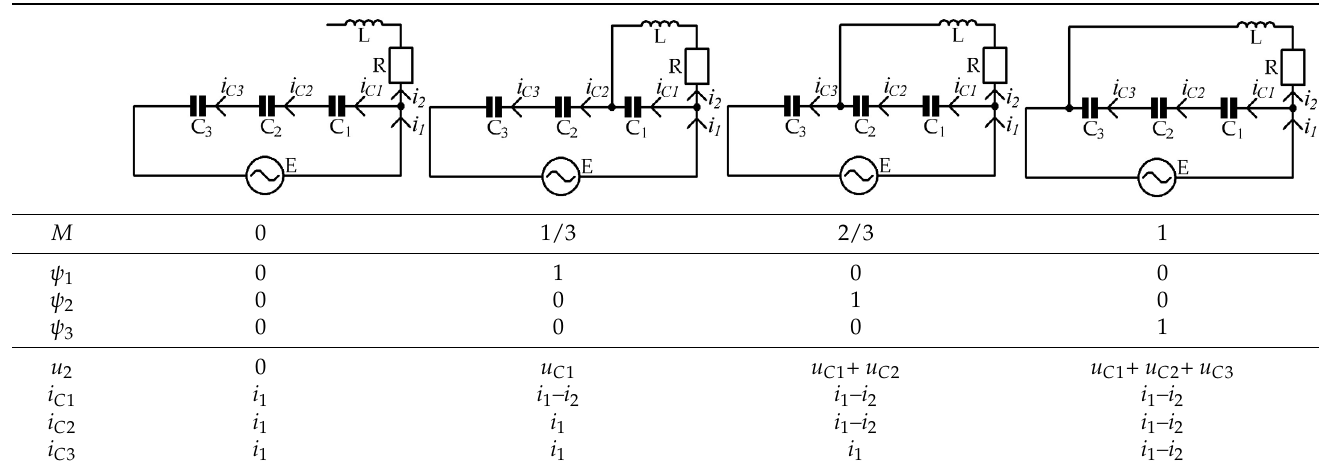
Table 1. Converter circuit modifications.